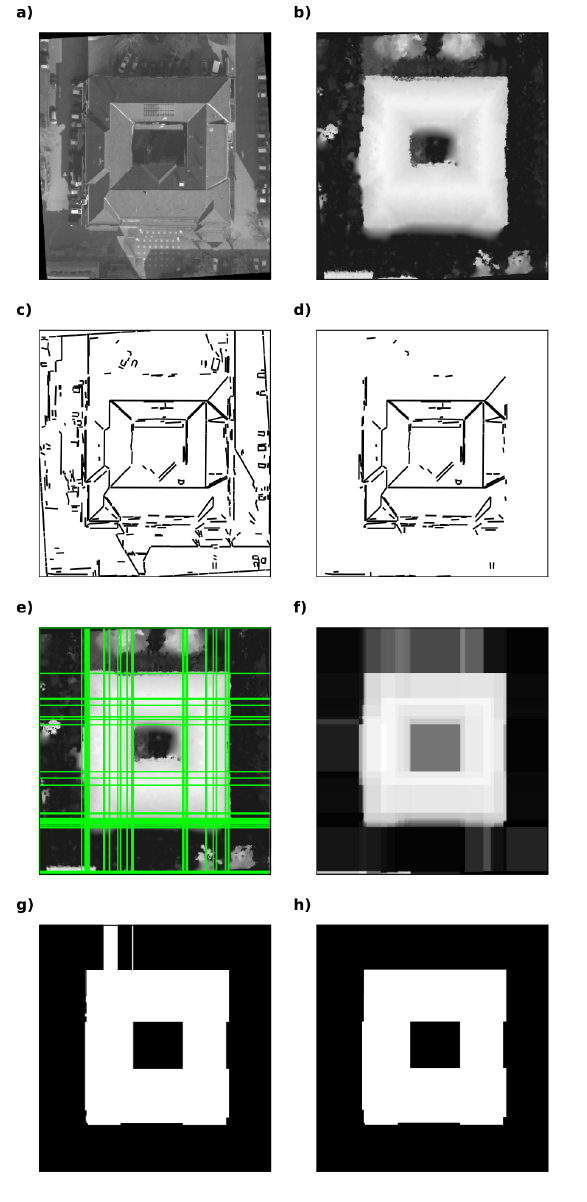
Figure 2: Footprint detection workflow; (a) rotated panchromatic aerial image, (b) normalized DSM (nDSM), (c) detected line seg- ments using the LSD algorithm, (d) line segments fulfilling the gradient criteria, (e) extended line segments that fulfill the orien- tation criteria, (f) averaged grids, (g) thresholded image filtered by standard deviation, (h) image after morphological filtering